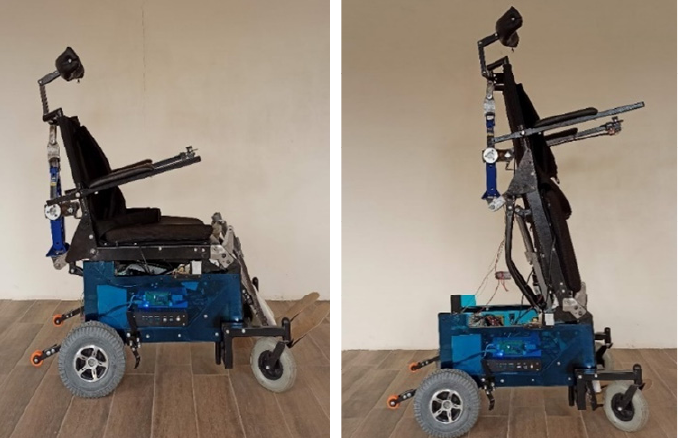
Figure 3. Robotic standing wheelchair built by the